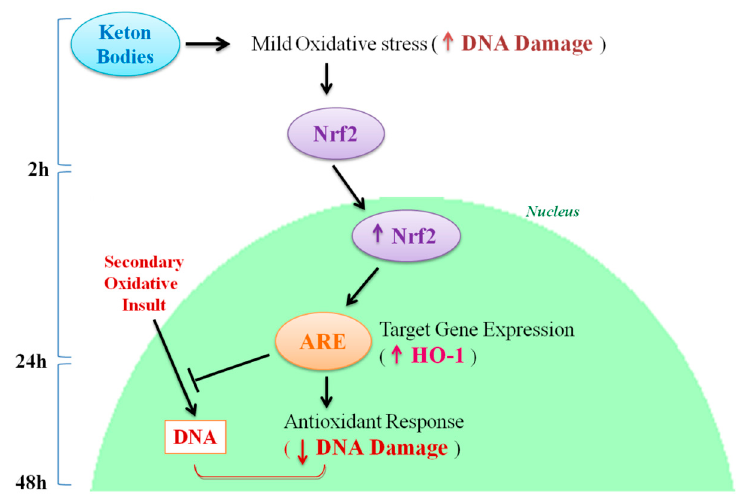
Figure 6. Proposed mechanism of action of KB in HMEC-1 cells.